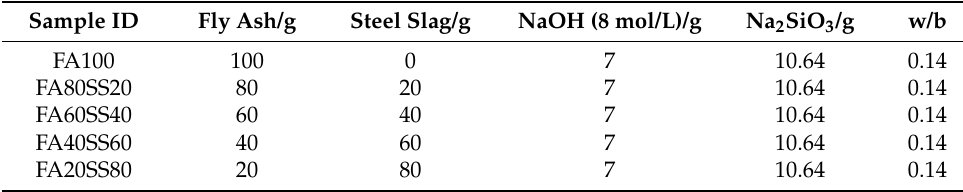
Table 2. Mix proportions of the